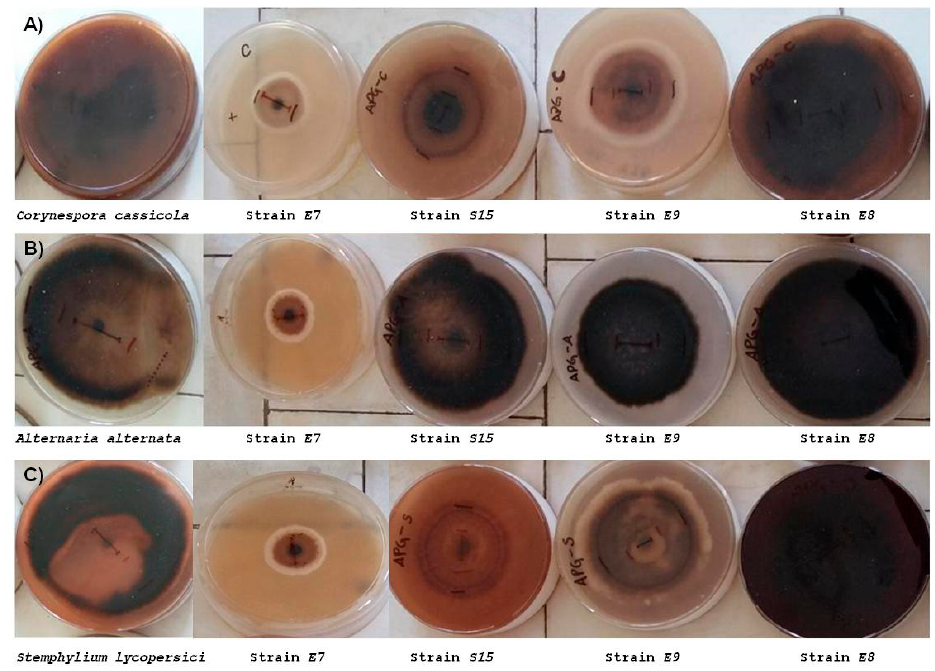
Figure 5. Effect on fungal pathogen growth of volatile compounds (VOCs) produce by endophytic bacteria, E7, S15, E9 and E8, against fungal pathogens: ( A ) C. cassiicola, ( B ) A. alternata , ( C ) S. lycopersici .